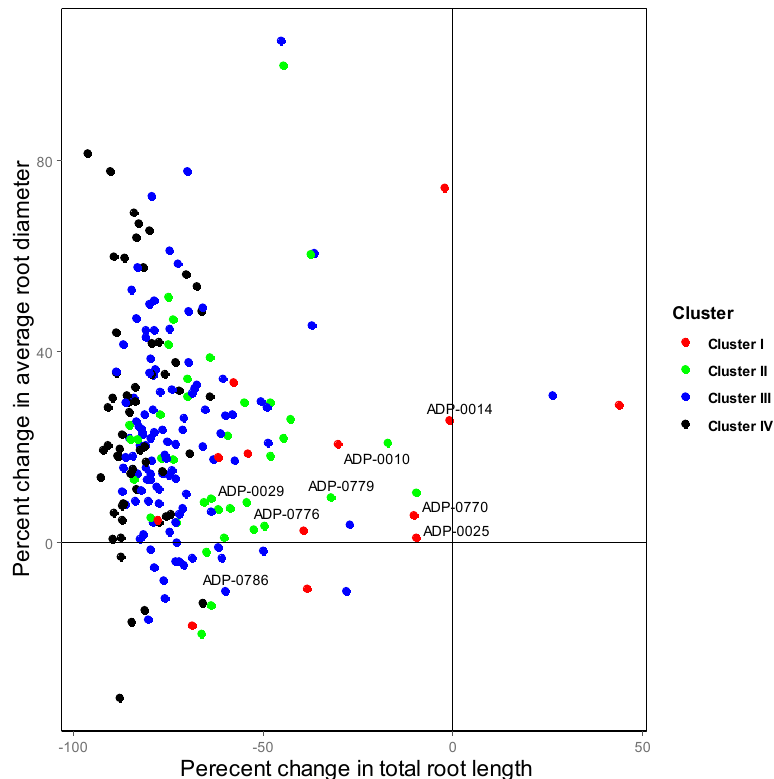
Figure 5. Scattergram identifying Andean bean genotypes from ADP with a low percentage total reduction in root length and low percentage increase in average root diameter. Colors as in Figure 4 for the four clusters of genotypes.